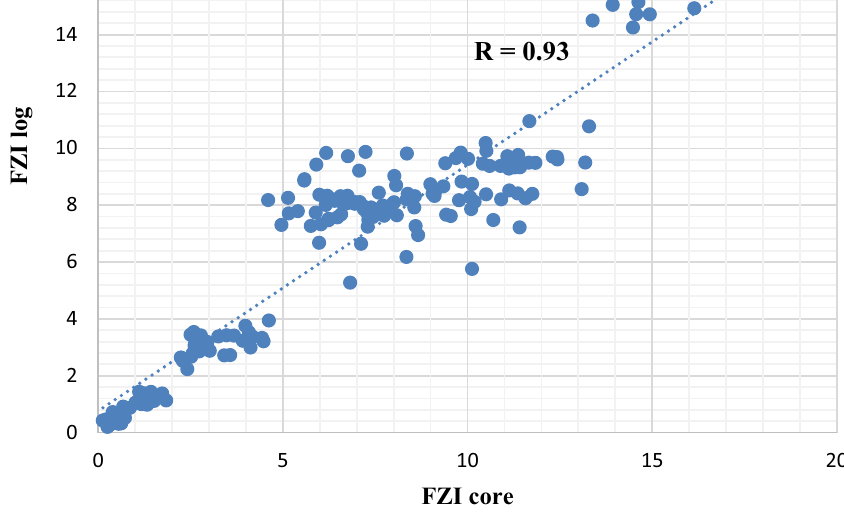
Fig. 10 Cross-plot of FZI core versus FZI log for all reservoir HFUs